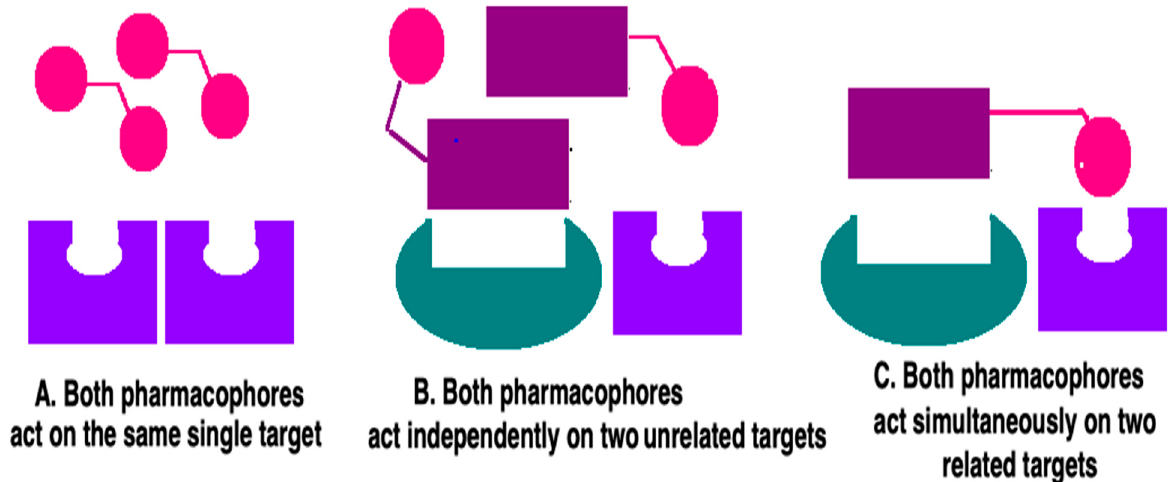
Figure 4. Mode of hybrid drugs related to target interactions.